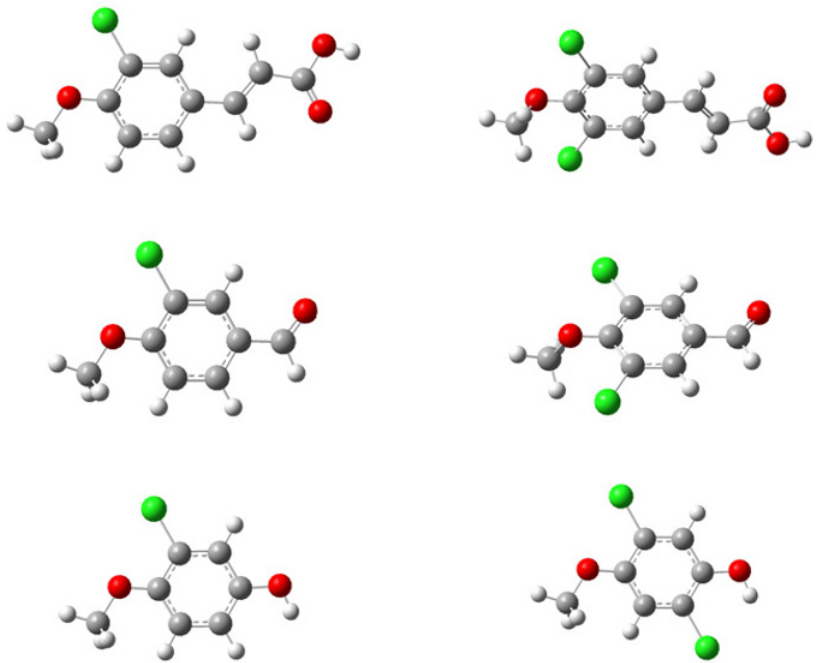
Figure 7. Visual representation of mono- and dichlorinated 4-MCA, 4-MBA and 4-MP derivatives detected in the EHMC/H